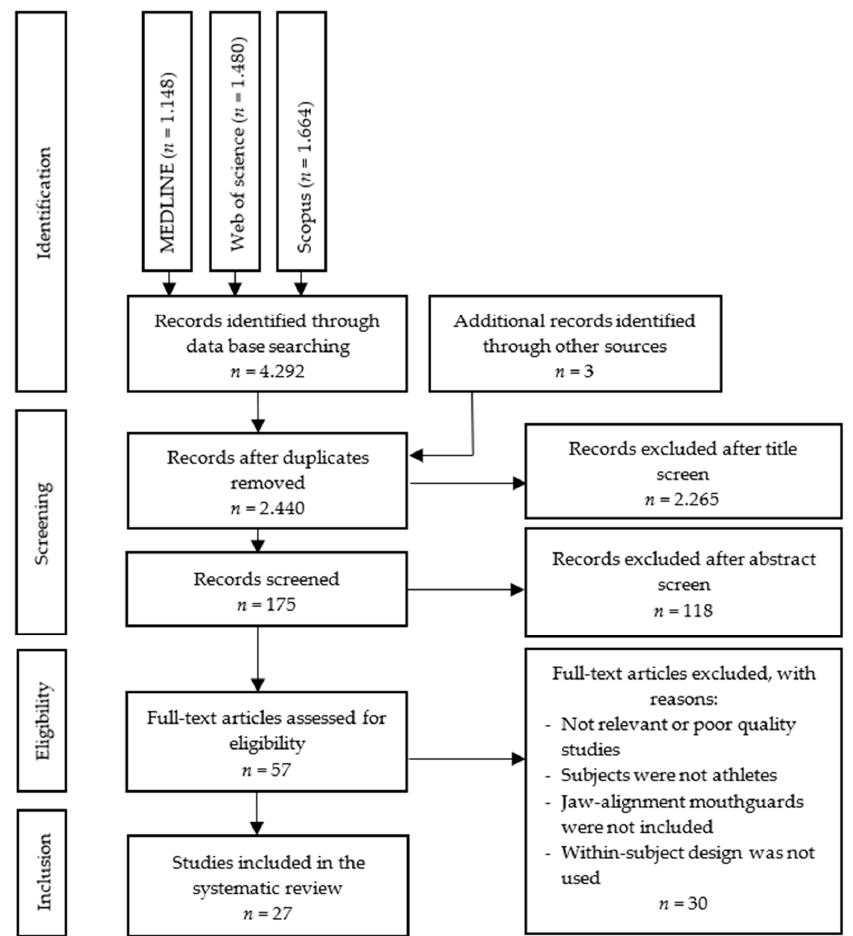
Figure 1. Flowchart of the search and study selection.